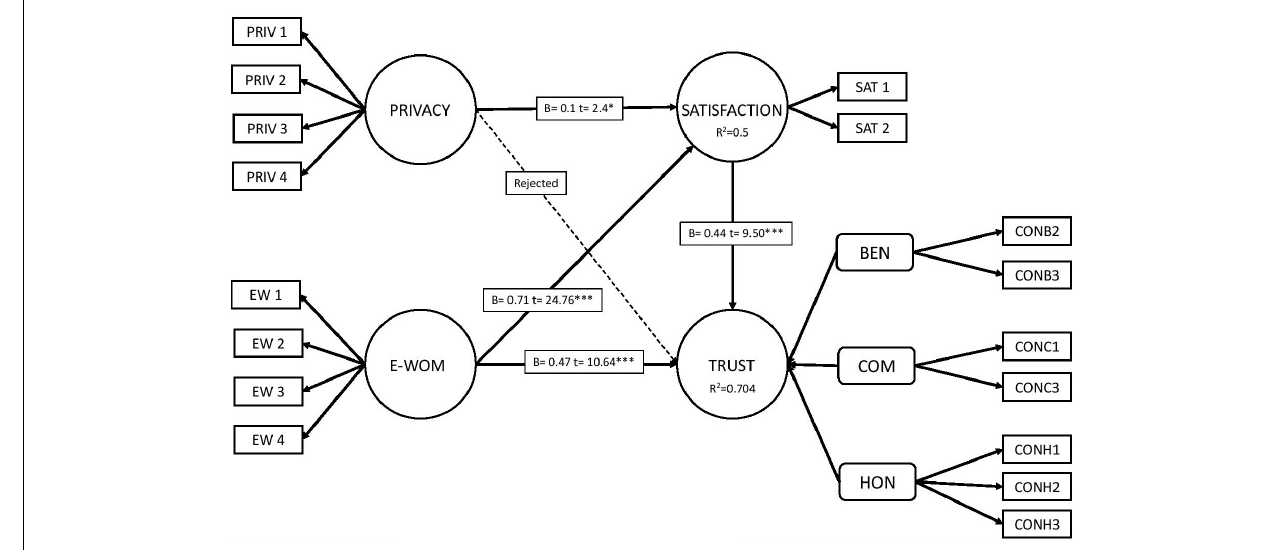
FIGURE 2 | Final model. Source: own elaboration. ∗∗∗ p <